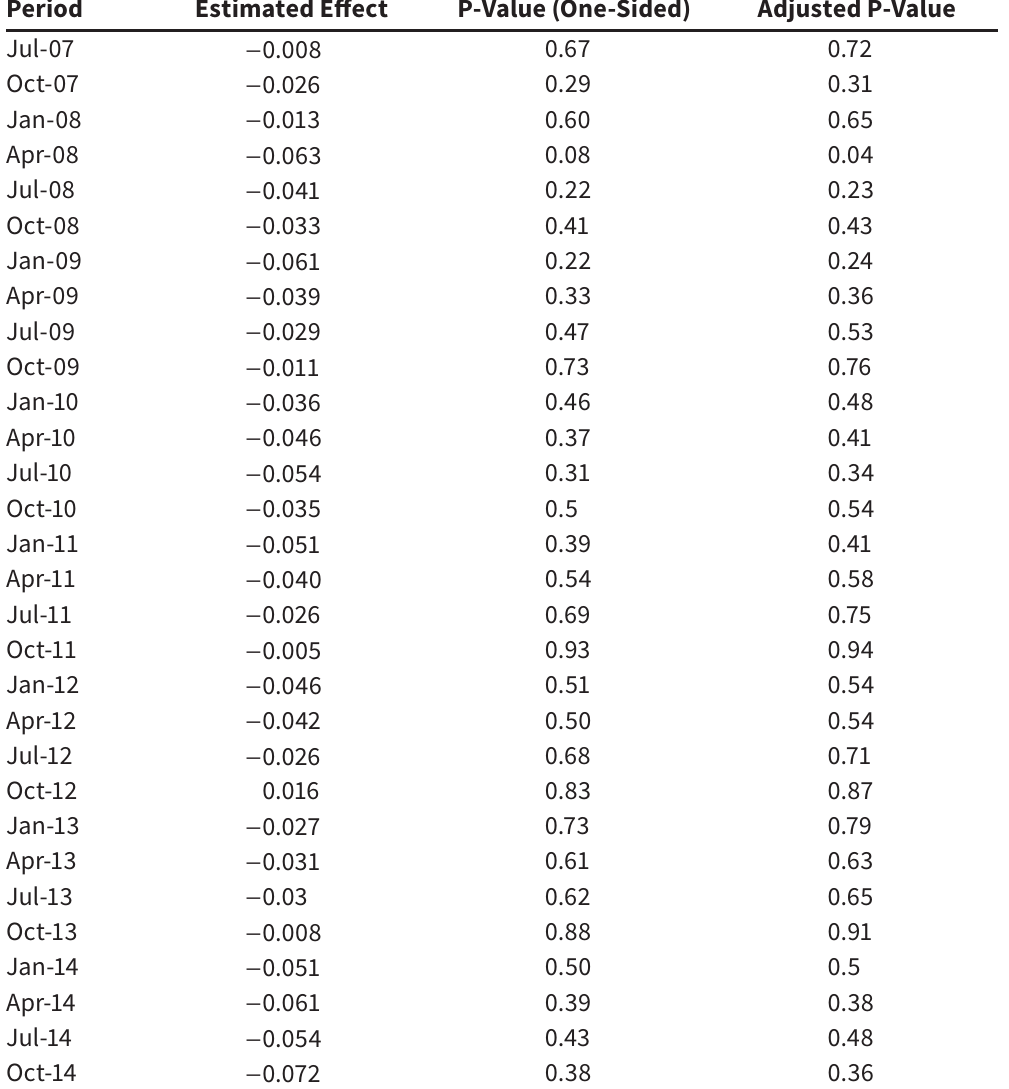
Table S10 Treatment Effects and Significance for Log Employment in Puerto Rican Accom- modation and Food Industry (USA Donors) (Truncated to Quarterly for Space) Period